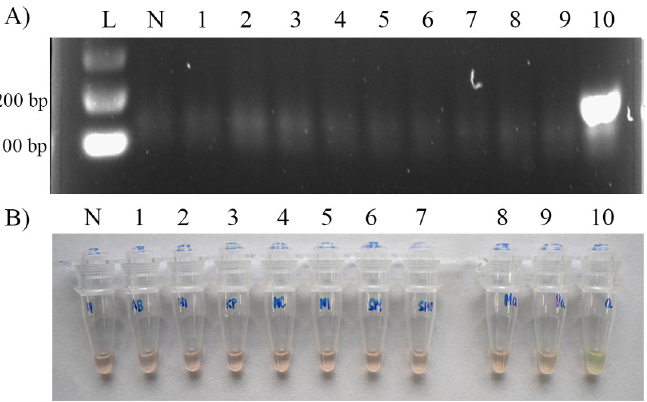
Fig 3. Specificity RPA testing. (A) Agarose gel electrophoresis showed the expected rpoB 526 RPA product when testing with wild-type M . tuberculosis H37Rv DNA only (lane 10). Lane L is a 100-bp DNA ladder, lane N is a no- template control, and lanes 1–9 are DNA extracted from A . baumannii , H . influenzae , K . pneumoniae , M . catarrhalis , M . intracellulare , S . pyogenes , S . pneumoniae , M . avium , and P . aeruginosa , respectively. (B) RpoB 526 RPA products were observed for the SYBR Green I colour change by the naked eye. Tube N is a no-template control, and tubes 1–9 are DNA extracted from A . baumannii , H . influenzae , K . pneumoniae , M . catarrhalis , M . intracellulare , S . pyogenes , S . pneumoniae , M . avium , and P . aeruginosa , respectively, showing an orange colour, which indicates no amplification. Tube 10 is M . tuberculosis H37Rv DNA, showing a green colour, which implies a positive amplification